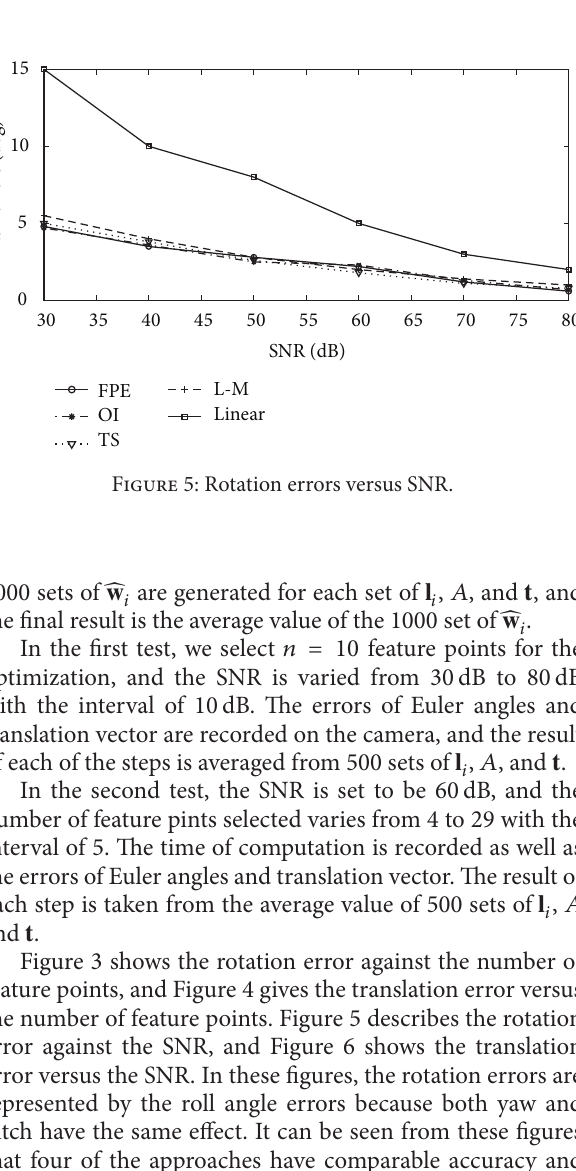
F 4: Translation errors versus the number of feature points.